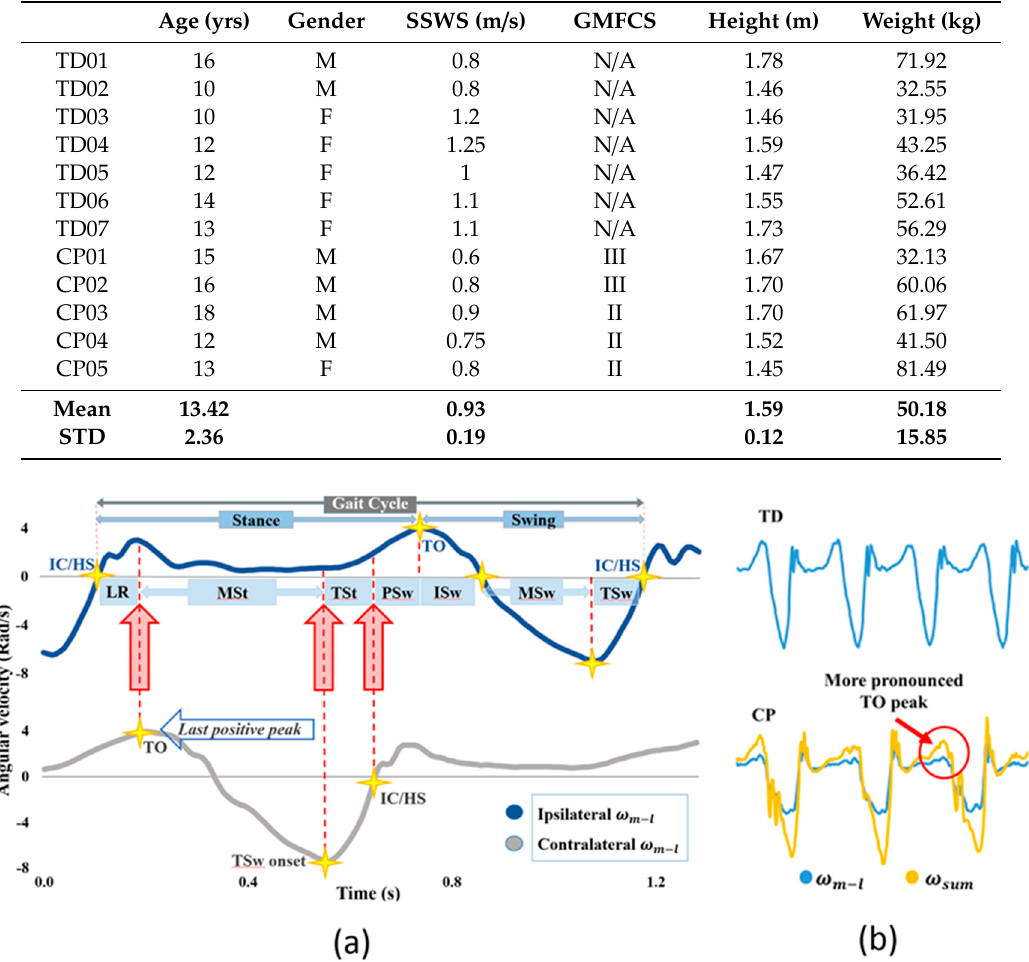
Table 1. Participant age, gender, Self-selected walking speed (SSWS), Gross Motor Function Classification System (GMFCS) level, height and weight.